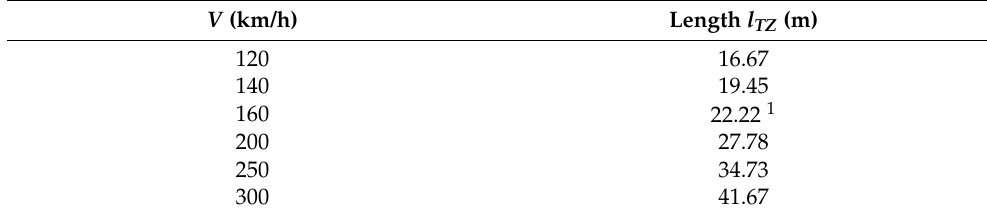
1 Figure 2 at V = 160